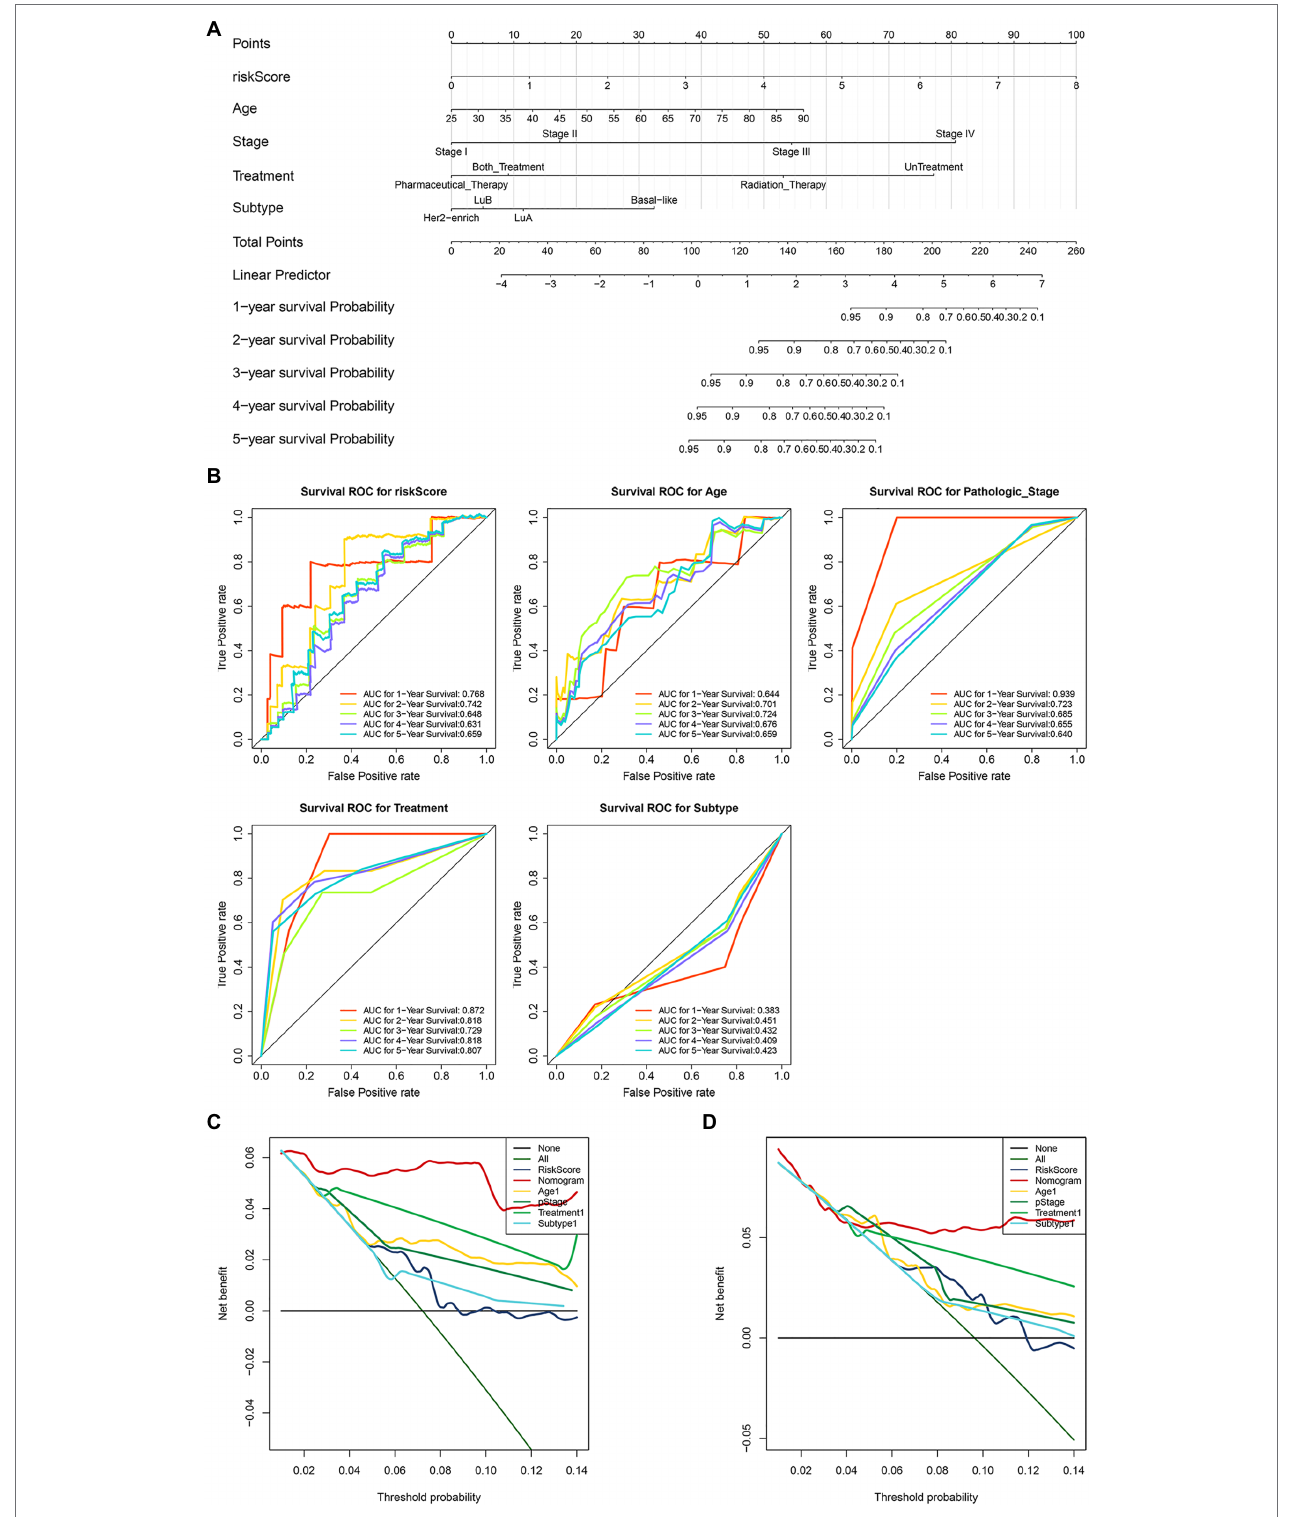
FIGURE 8 | Construction and validation of survival prediction nomogram in IDC. (A) A nomogram for predicting the survival rates of 1-, 2-, 3-, 4-, and 5-year. (B) ROC of prognostic signature of 4 COAGULATION-related genes, pathological_stage treatment, and molecular subtypes of IDC. (C) DCA decision curve for 3-year survival prediction. (D) DCA decision curve for 5-year survival